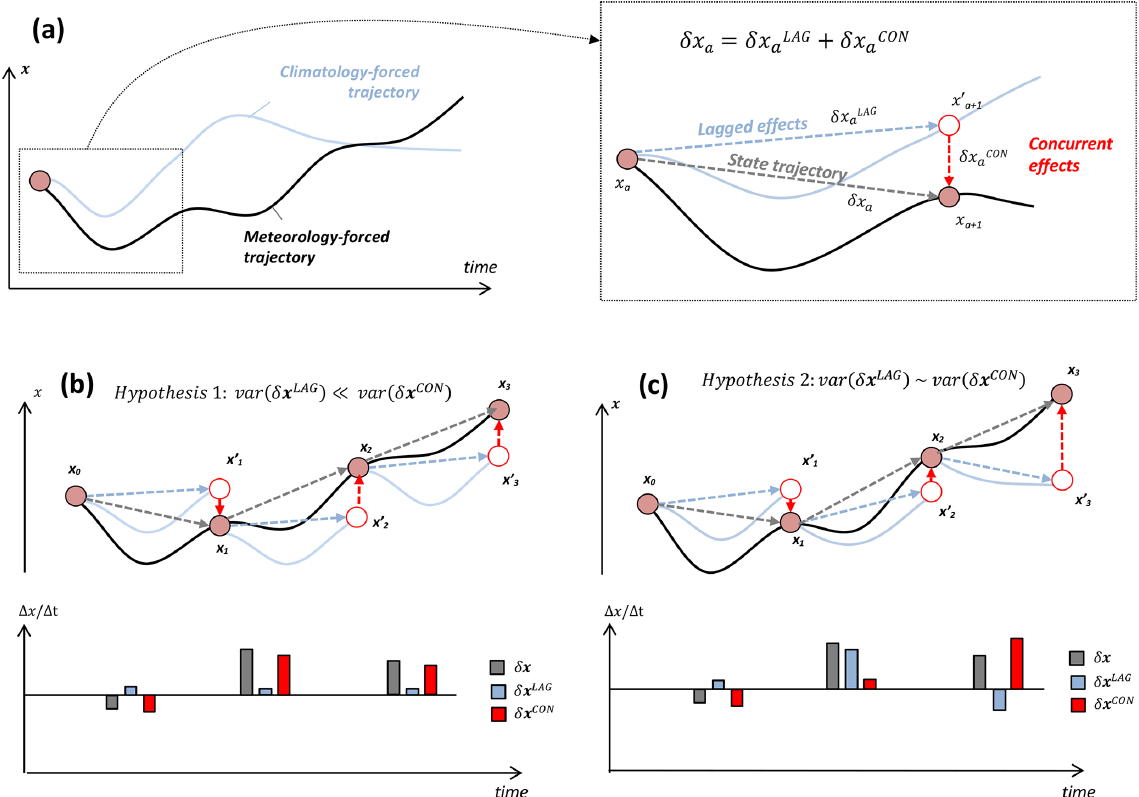
Figure 3. (a) Schematic of meteorology-forced trajectory of ecosystem state x (solid black line) and trajectory of x under a climatological mean forcing (light blue solid line). Inset: state trajectory x a → x a + 1 ( δx a ), decomposed as the sum of climatology-induced lagged effect vector x a → x (cid:48) a + 1 ( δx LAG a ) and anomaly-induced concurrent effect vector x (cid:48) a + 1 → x a + 1 ( δx CON a ). (b) Hypothetical scenario depicting approximately time-invariant annual lagged effects δ x LAG (blue dashed arrows), in reference to changes in transient states x 0 , x 1 , x 2 , etc.; the temporal changes in x for each time interval, δ x , δ x LAG and δ x CON , are shown in the underlying bar chart. In this scenario, δ x LAG is relatively constant and its variability (denoted as “var()” in the schematic equation) is negligible relative to δ x CON . (c) Hypothetical scenario depicting time-varying annual lagged effects δ x LAG , in reference to transient states x 0 , x 1 , x 2 , etc.; in this scenario, the variability of δ x CON is comparable to the variability of δ x LAG